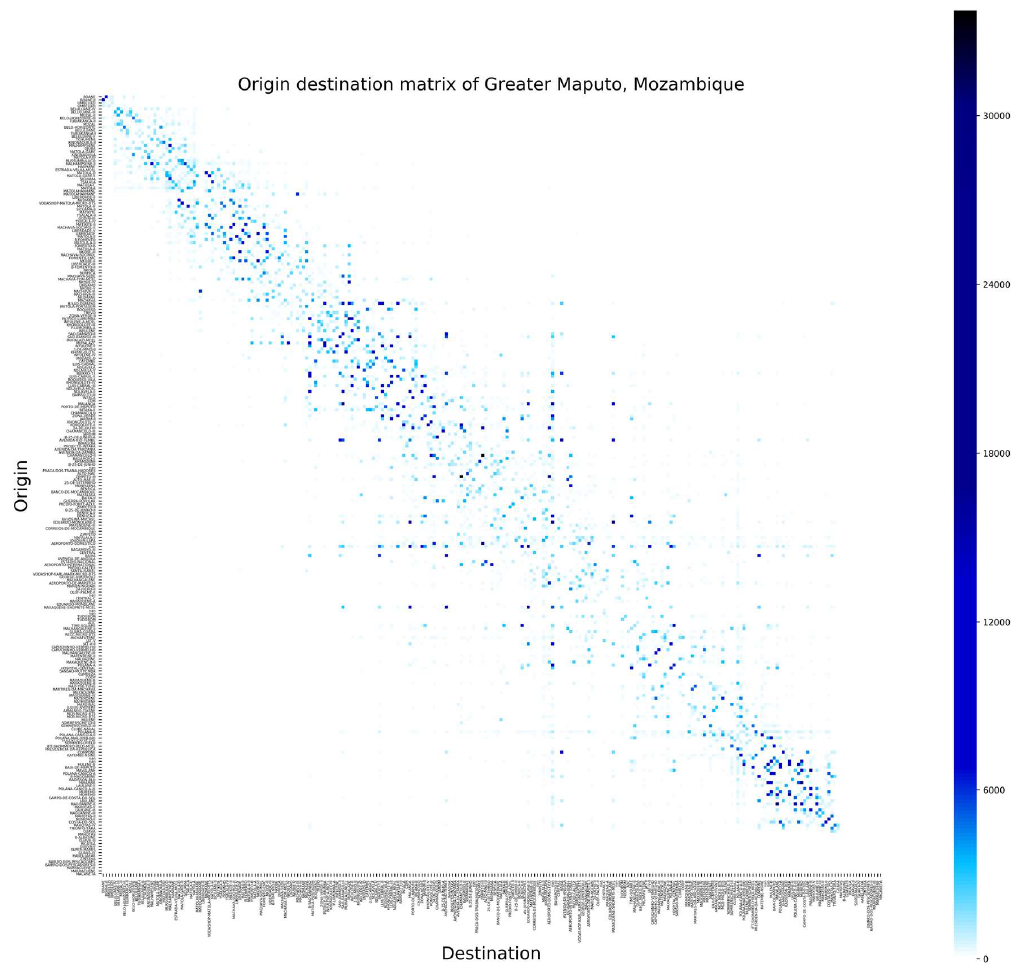
Figure 17. Constructed origin–destination (OD) matrix of the study area.